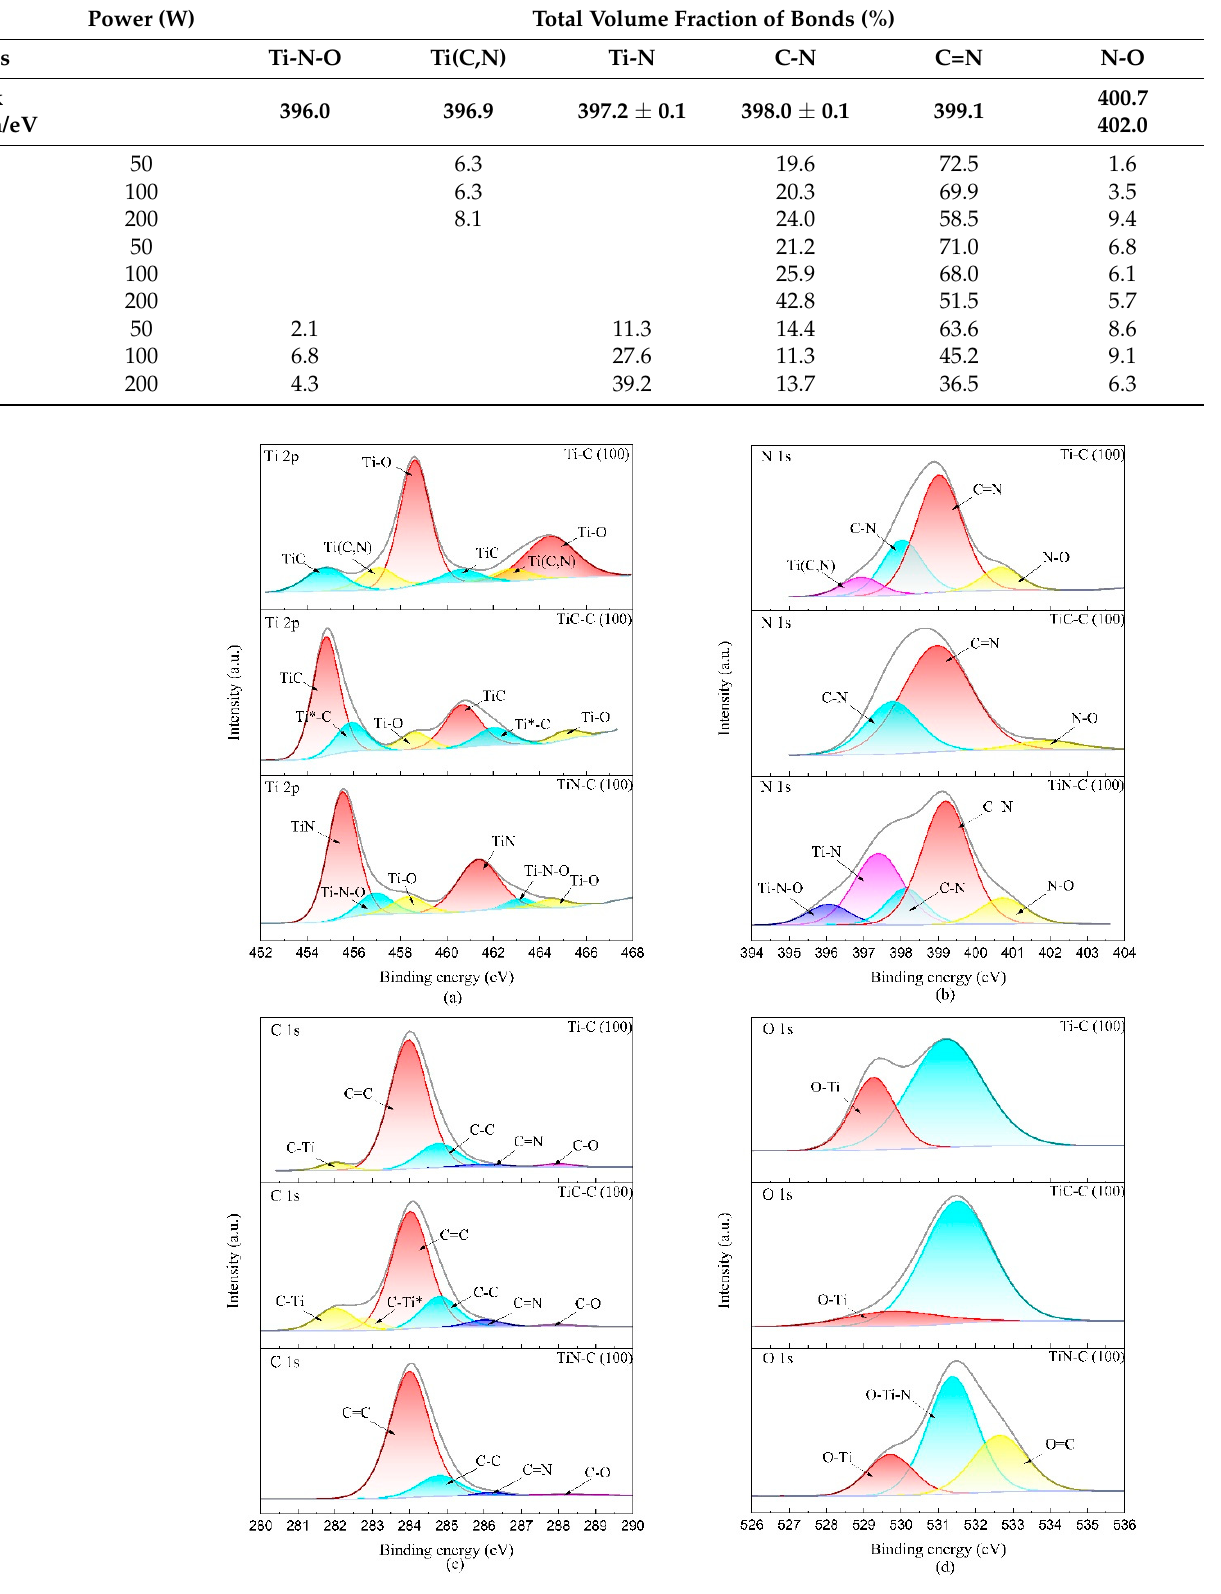
Figure 6. XPS analysis of (Ti:N)-GLC films: ( a ) Ti 2p; ( b ) N 1s; ( c ) C 1s; ( d ) O 1s. Table 2. XPS analysis results of Ti 2 p.